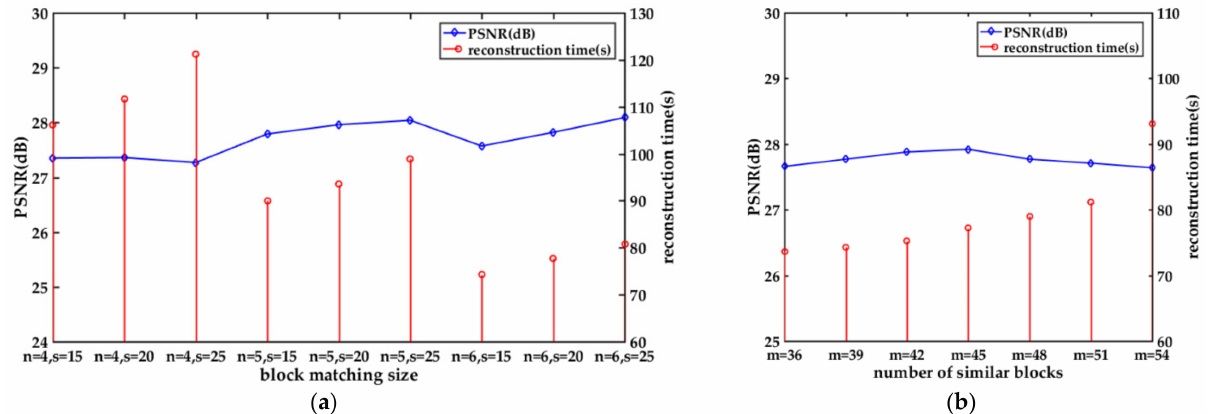
Figure 2. The PSNR (dB) and reconstruction time(s) of the Monarch image with different ( a ) block sizes ( n 2 ) and search window size ( s 2 ), ( b ) number of similar blocks ( m ) reconstructed by the proposed